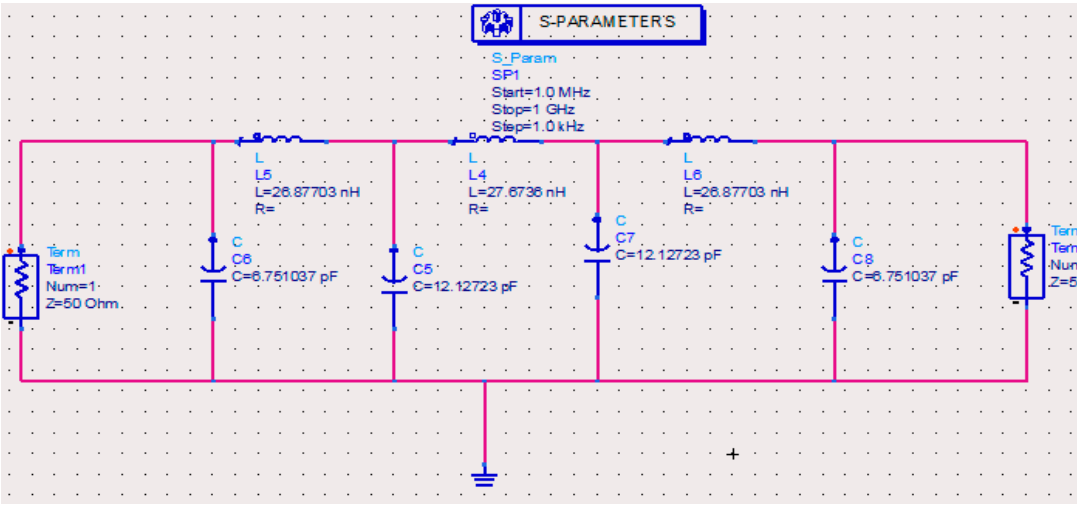
Figure 8. Low-pass Pascal filter with de- normalized passive elements, in ADS 2011.